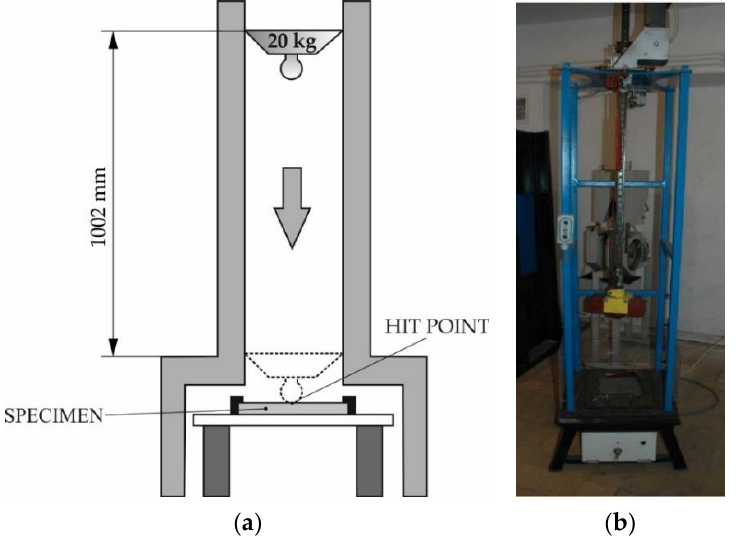
Figure 8. Test rig used in the tests of the impact resistance of the surface layer: ( a ) schematic diagram and ( b ) main view [21].